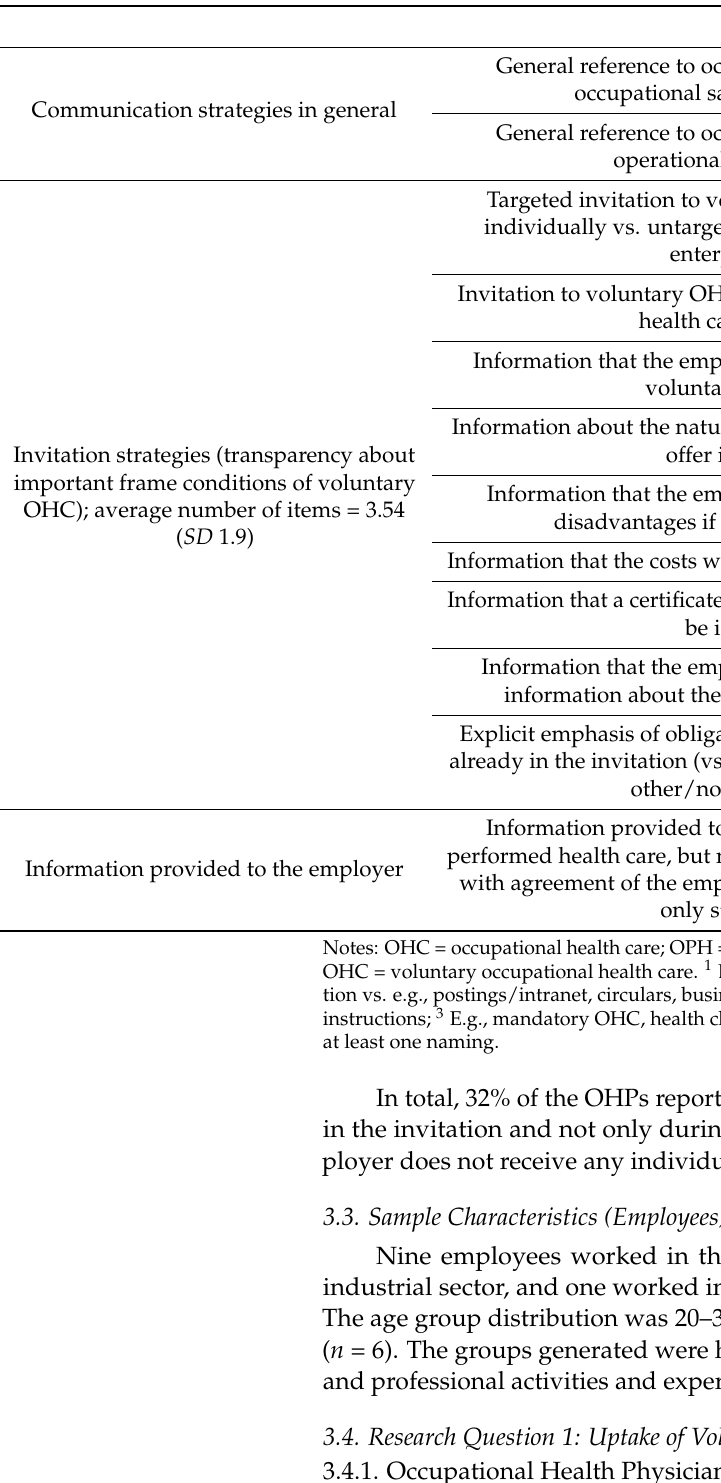
Table 3. Details about how employees are informed about voluntary occupational health